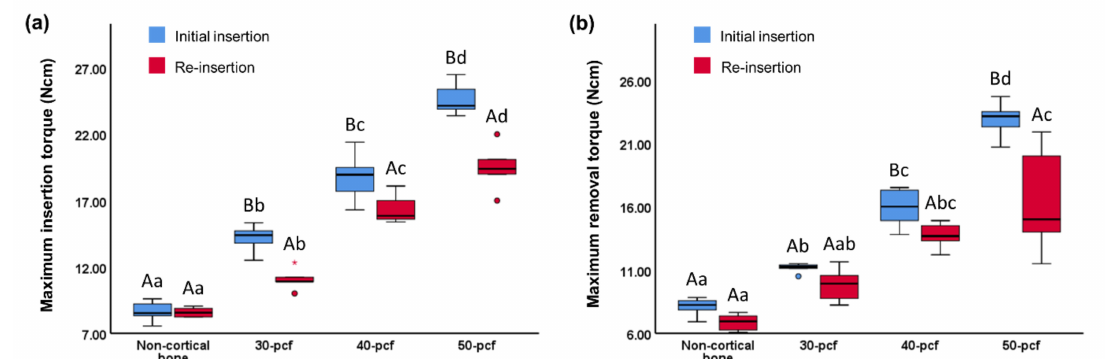
Figure 5. ( a ) Maximum insertion torque and ( b ) maximum removal torque values during the initial insertion and re-insertion of miniscrews into cortical bone with varying densities. Di ff erent uppercase letters indicate a significant di ff erence between the initial insertion and re-insertion ( P < 0.05). Di ff erent lowercase letters indicate a significant di ff erence between the various cortical bone densities ( P < 0.05).